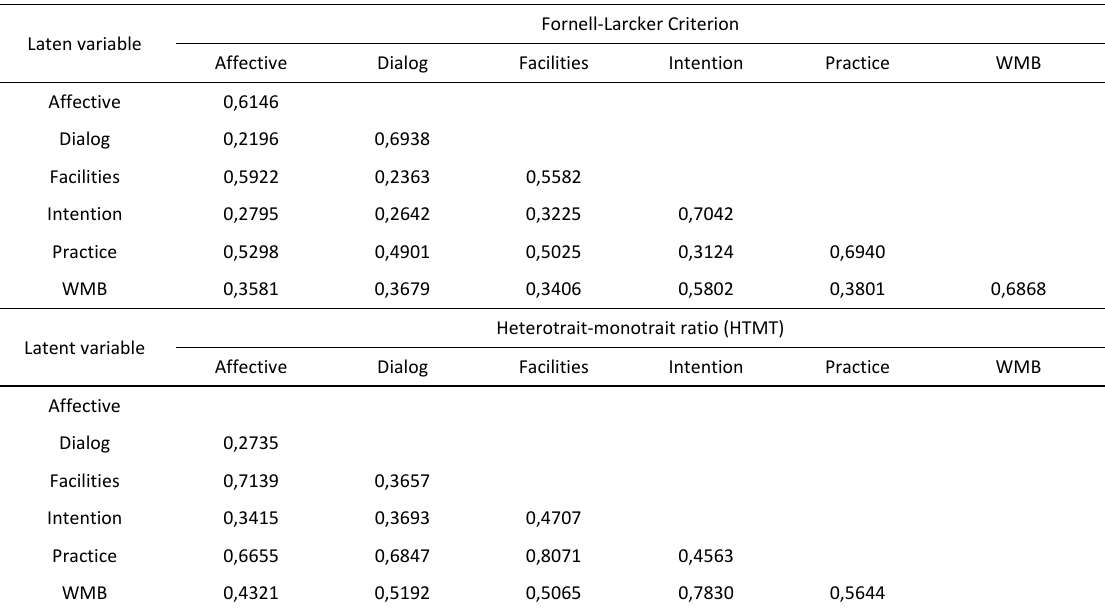
Fig. 6: Learning sources of residents in ZWA Program Table 5: The discriminant validity of the revised model